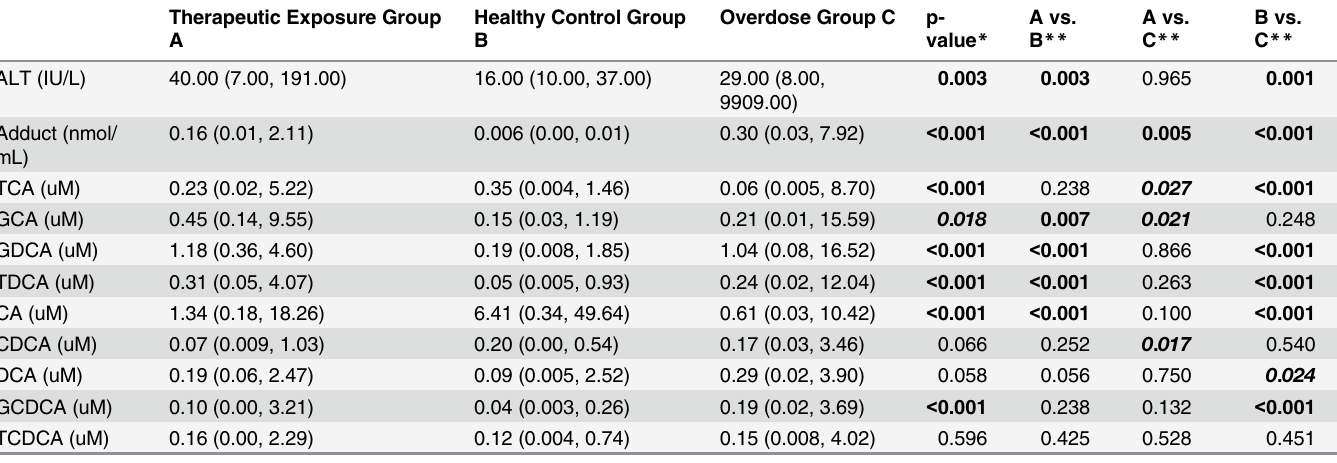
Table 2. Summary data for peak alanine aminotransferase values (ALT), acetaminophen (APAP) protein adducts, and bile acids by group. Therapeutic Exposure Group